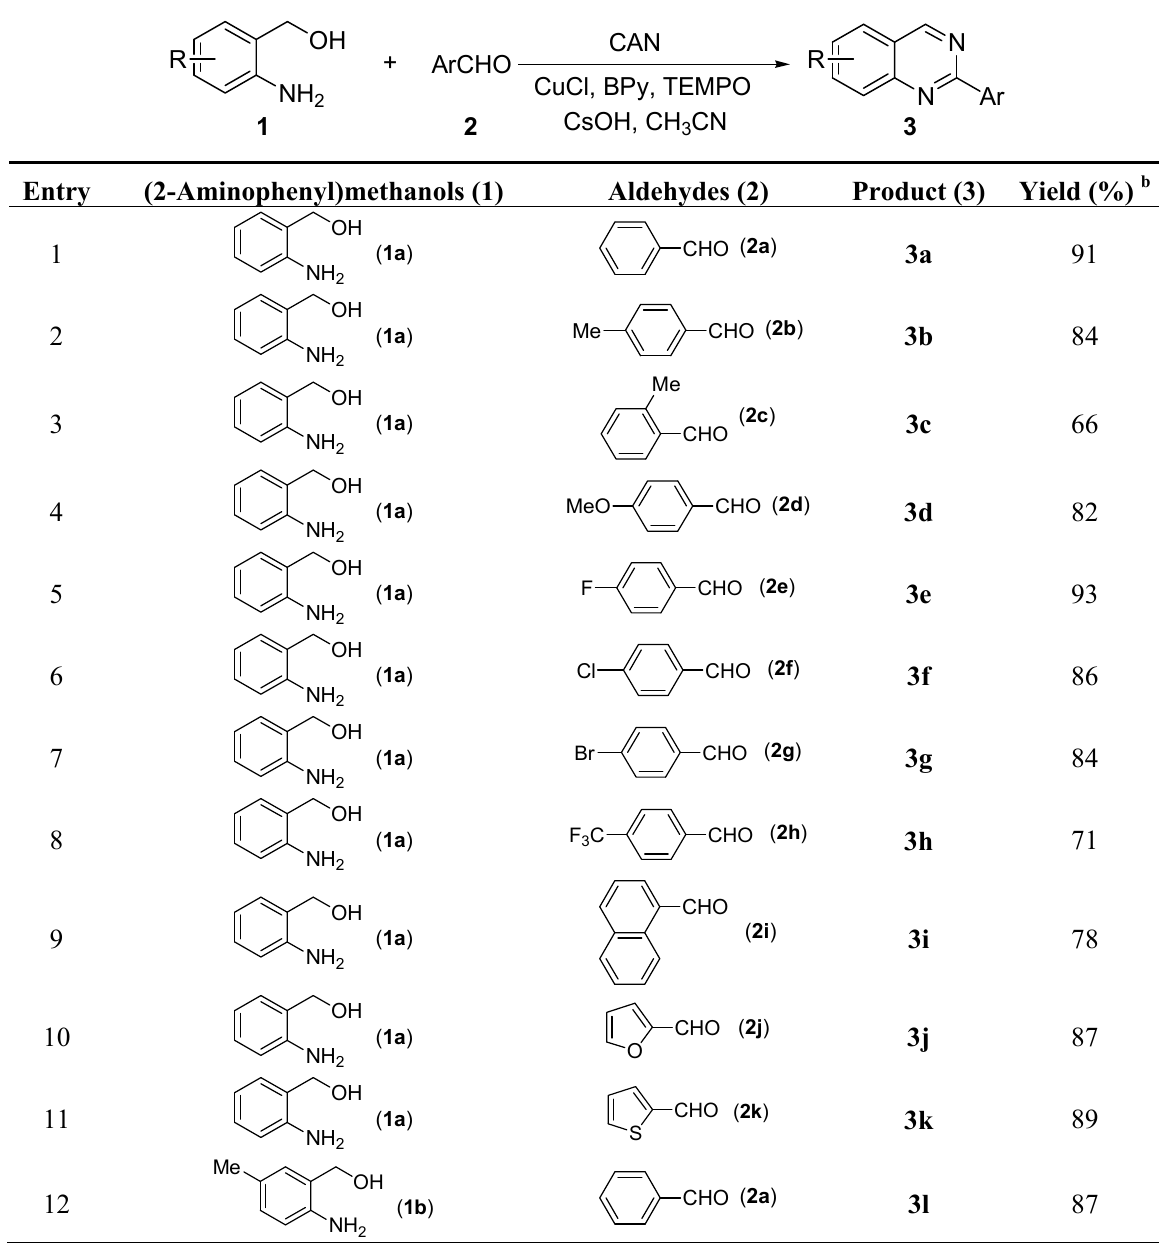
Table 2. Substrate scope of (2-aminophenyl)methanols and aldehydes a